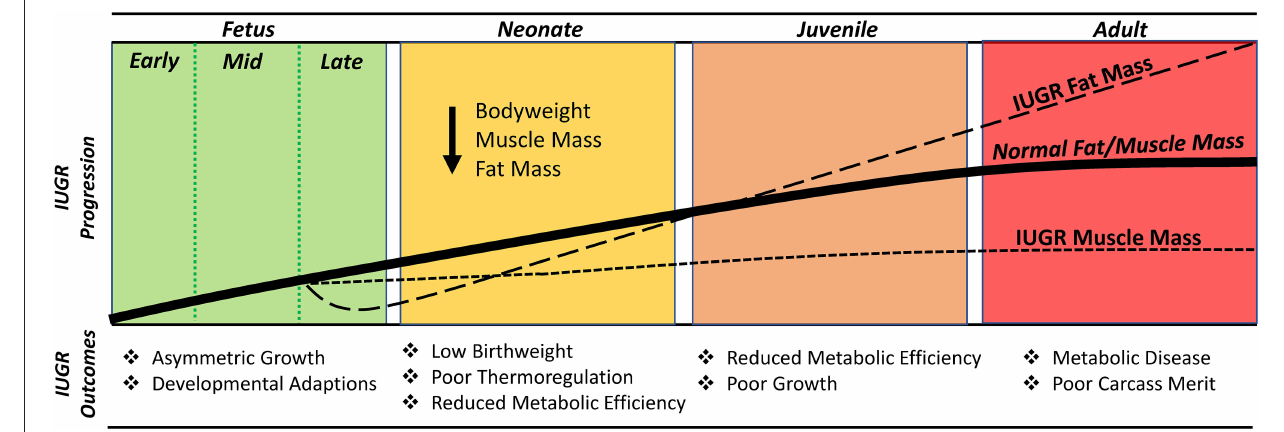
FIGURE 3 | Timeline illustrating the changes in muscle growth capacity and fat deposition in the IUGR fetus/offspring relative to a normal (i.e., uncompromised)